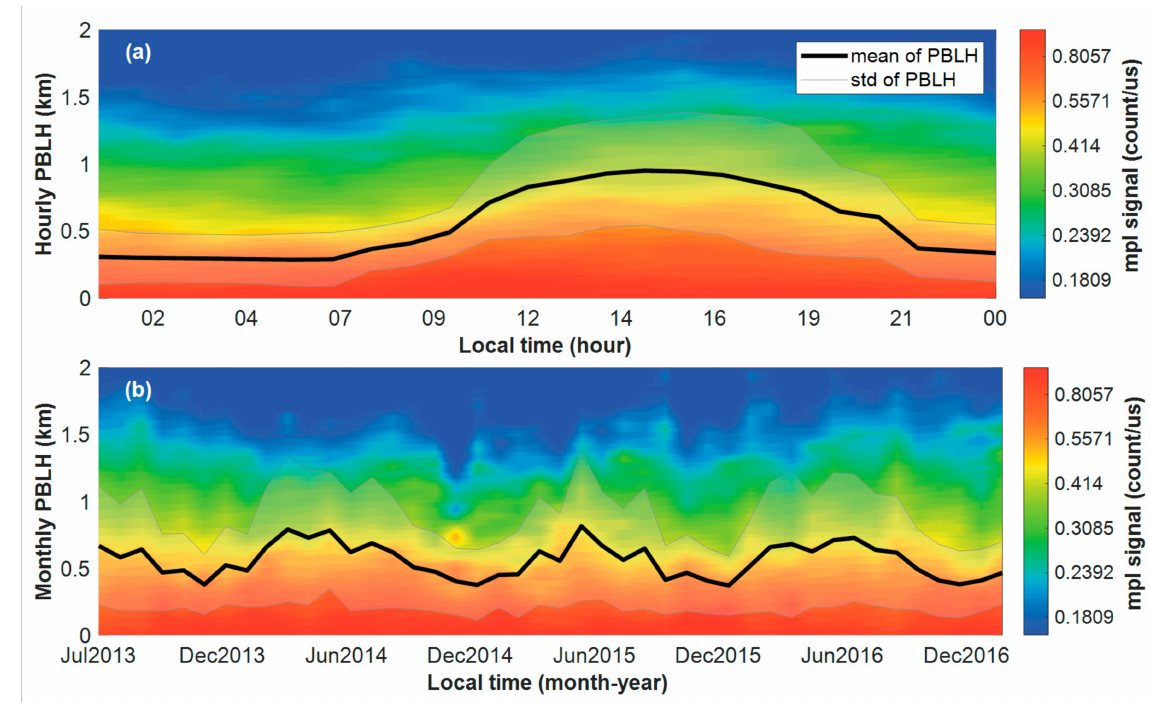
Figure 7. ( a ) Hourly mean of PBLHs and ( b ) monthly mean of PBLHs from 2013 to 2016; the black line refers to the PBLHs; the black shaded areas indicate the standard